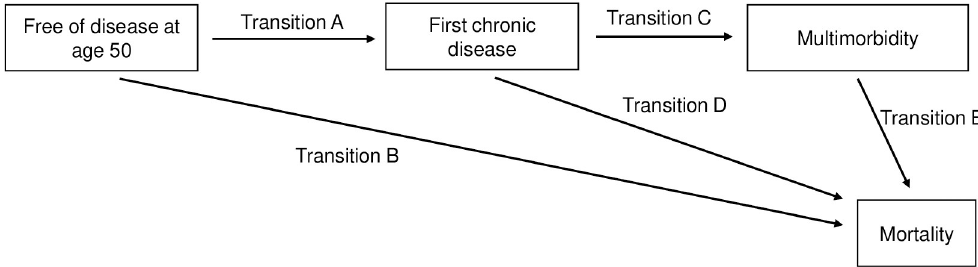
Fig 1. Schematic representation of the transitions from start of follow-up (free of chronic disease at age 50) to a first chronic disease, multimorbidity, and mortality. Transition A represents the transition from a healthy state at age 50 (free of the 13 chronic diseases considered) to a first chronic disease (any from the list of 13 diseases considered); Transition B represents the transition from a healthy state to death among those who remained free from any of the 13 diseases during follow-up; Transition C represents the transition from a first chronic disease to multimorbidity (occurrence of a second disease among those with 1 chronic disease); Transition D represents the transition from a first chronic disease to death among those who remained free from multimorbidity during the follow-up; and Transition E represents the transition from multimorbidity to death.